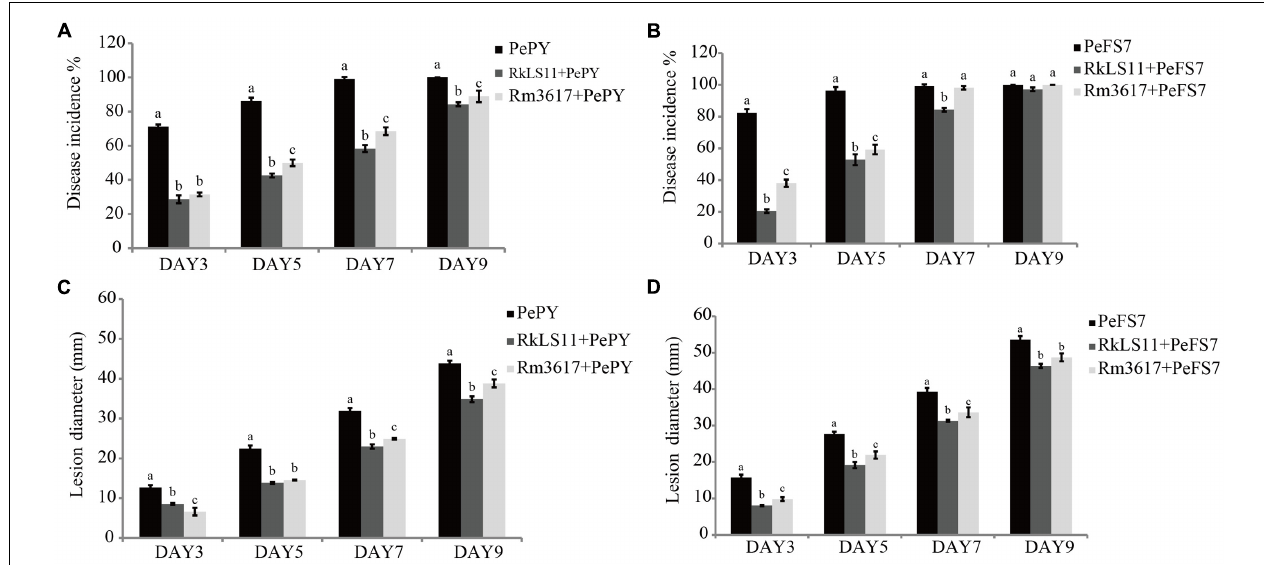
FIGURE 1 | Time course of biocontrol activity of Rhodotorula mucilaginosa 3617 and Rhodotorula kratochvilovae LS11 against blue mold decay of apples. (A) Decay incidence (%) of infected wounds caused by Penicillium expansum strain PePY. (B) Decay incidence (%) caused by P. expansum strain PeFS7. (C) Lesion diameter (mm) of apples infected by P. expansum strain PePY. (D) Lesion diameter of apples infected by P. expansum FS7. PePY, P. expansum strain PY; PeFS7, P. expansum strain PeFS7; Rm3617, Rhodotorula mucilaginosa strain 3617; RkLS11, R. kratochvilovae strain LS11. Bars represent the mean values from two experiments ± standard deviations. Values marked with different letters are significantly different ( P <